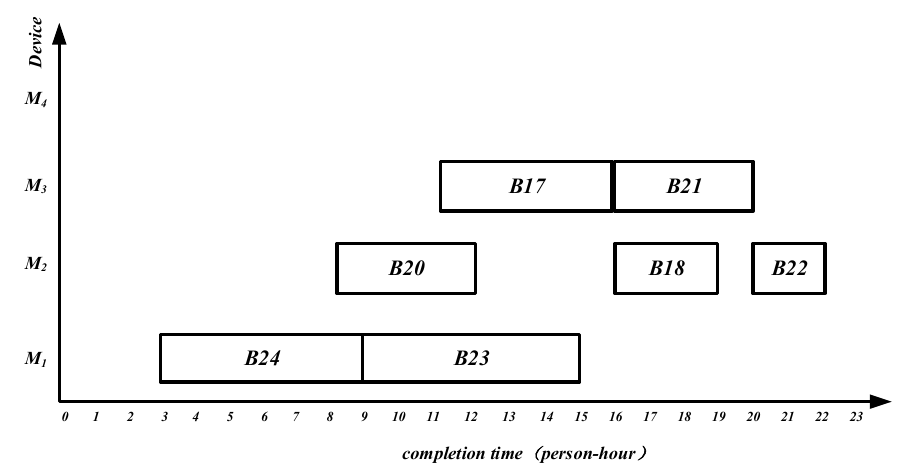
with 22 person ‐ hours. 1